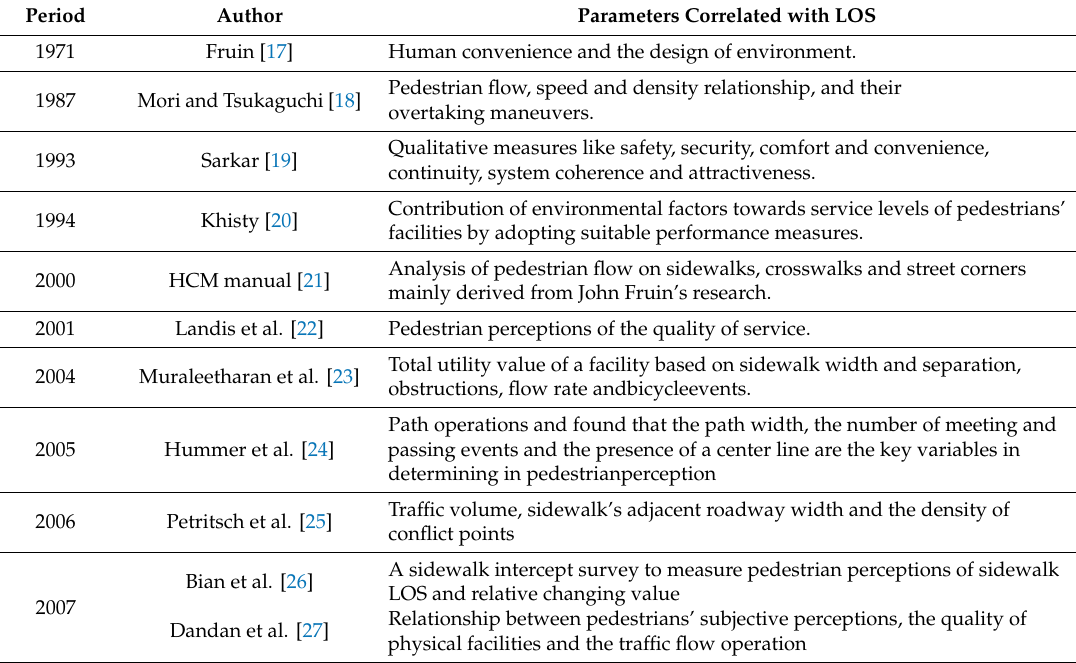
Table 1. Evaluation of LOS during the period